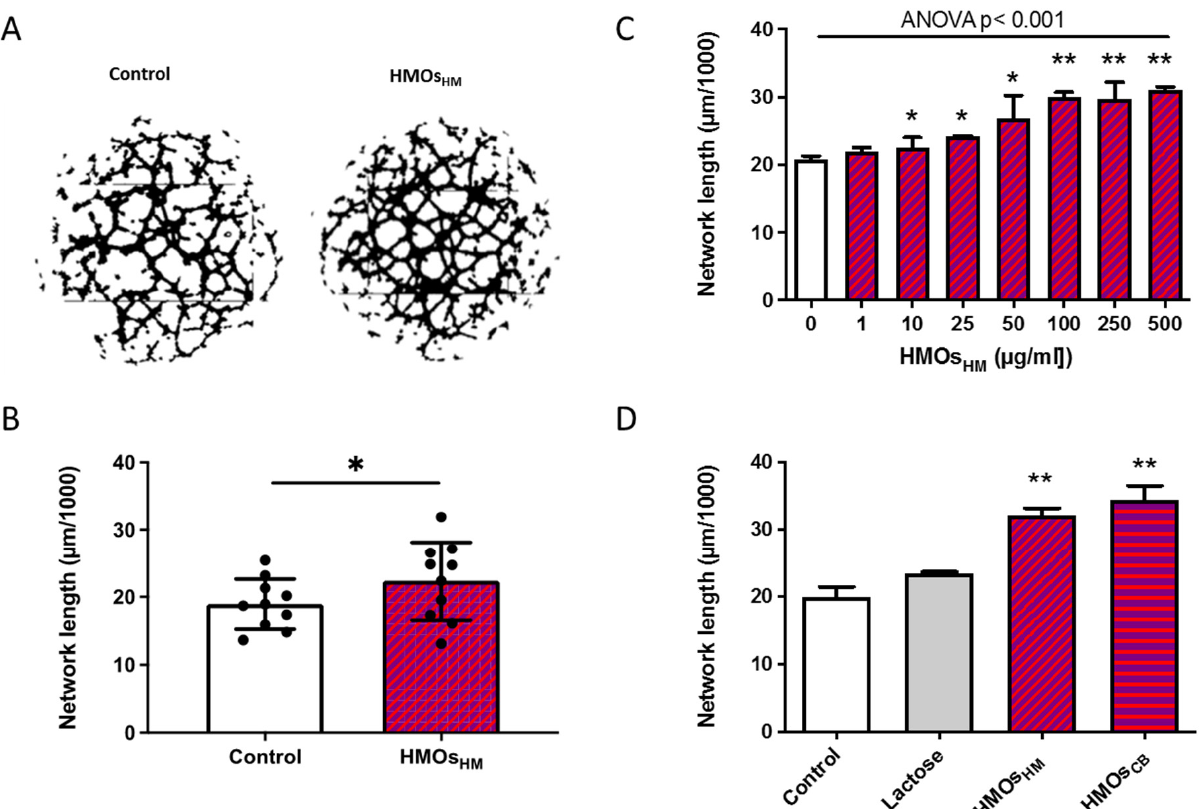
Figure 2. Human milk oligosaccharides (HMOs) dose-dependently increased network formation in primary fpECs. fpECs were pre-incubated for 24 h with EBM medium supplemented with 5% FCS with or without HMOs prior to use in a 2D network formation assay (Matrigel). ( A ) Representative images of network formation after 24 h treatment with (right) or without (left) pooled HMOsHM prior to use in a 2D network formation assay. ( B ) Bar plot shows total tube length at 12 h after seeding. A set of n = 10 fpEC isolations from healthy placentas was used, each in 2 to 3 independent experiments in technical triplicates (mean ± SD, n = 10, paired T -test). ( C ) fpECs were treated with serial concentrations (0–500 µ g/mL) of pooled HMOsHM and incubated for 24 h showing a dose-dependent effect on 2D network formation. Two independent experiments were performed with two different fpEC isolations in triplicates (means ± SEM, ANOVA with multiple comparison). ( D ) Network formation was similarly increased when fpECs were incubated with HMOs isolated from pooled human milk (HMOsHM) as from pooled cord blood (HMOsCB red- purple vertically striped) and significantly different to no treatment and non-HMO control for 24 h. Two independent experiments were performed with two different fpEC isolations in triplicates; means ± SEM, paired t -test shows significance difference vs. control (white bar). * p < 0.05; ** p < 0.01. CB, cord blood; HM, human